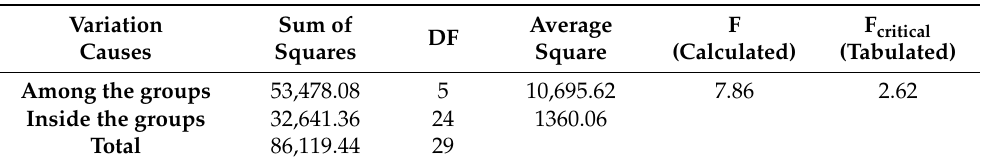
Table 3. ANOVA results of average ultimate tensile strength obtained for seven-islands-sedge of for different mean diameters